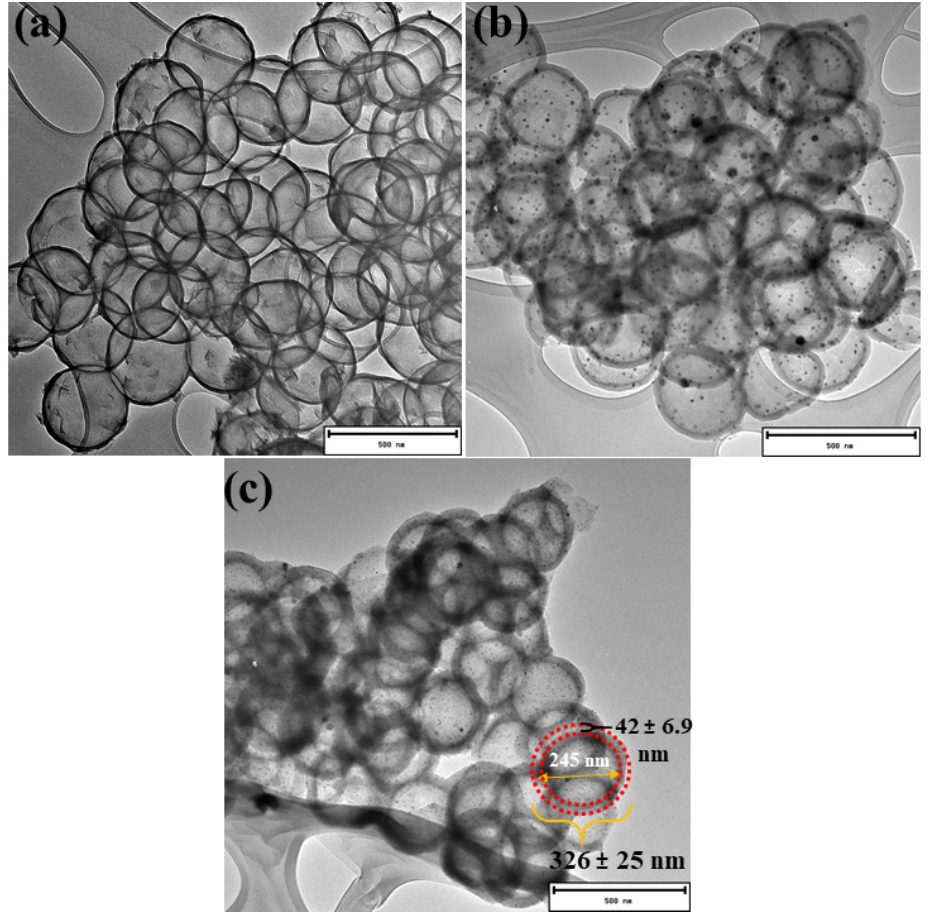
Figure 2: Low magnification TEM micrographs of ( a ) pristine HCSs, and Ni@HCSs samples after using ( b ) NiCl 2 , and ( c ) Ni(acet) 2 precursors (scale bar 500 nm).